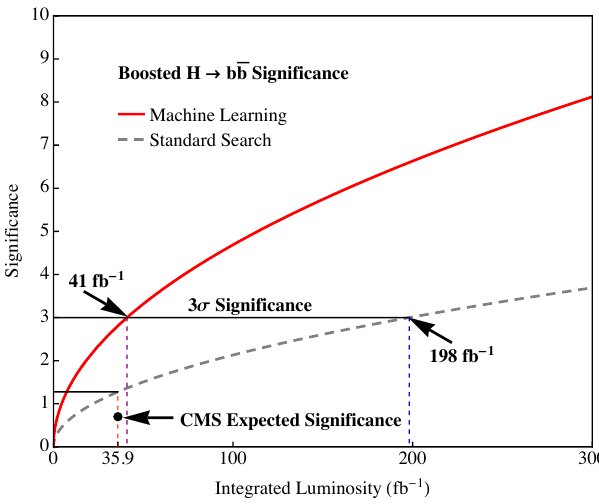
Figure 4 . The expected signi(cid:12)cance as a function of the integrated luminosity for the analysis with and without machine learning. The vertical red dashed line corresponds to the dataset size from the current CMS result [19] while the purple and blue dashed lines indicate the sizes required to reach 3 (cid:27) with and without machine learning, respectively. The full Run 2 (2015{2018) dataset will be about 150 fb (cid:0) 1 and the full LHC dataset (up to 2023), prior to the HL-LHC, will be about 300 fb (cid:0) 1